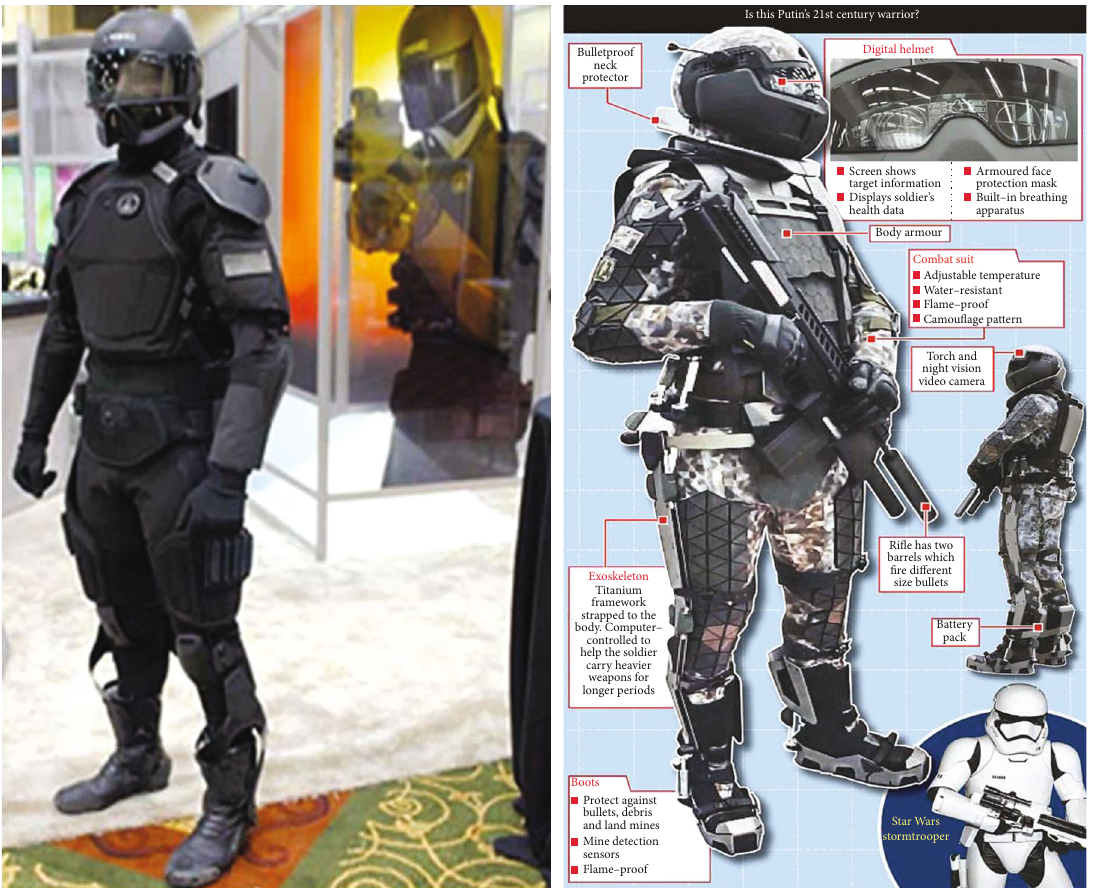
Figure 5: Russian advanced high-tech amour item that includes an exoskeleton or the outer layer, designed to boost strength and stamina